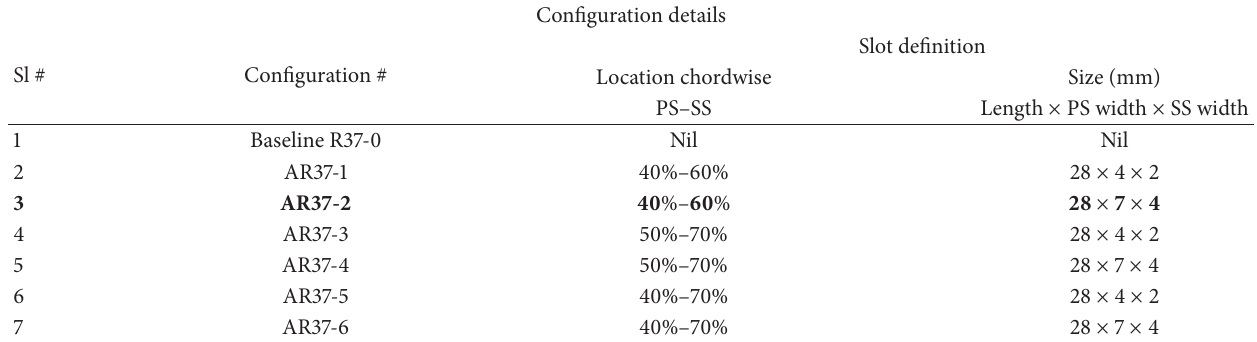
Table 1: Geometric details of aspiration slot